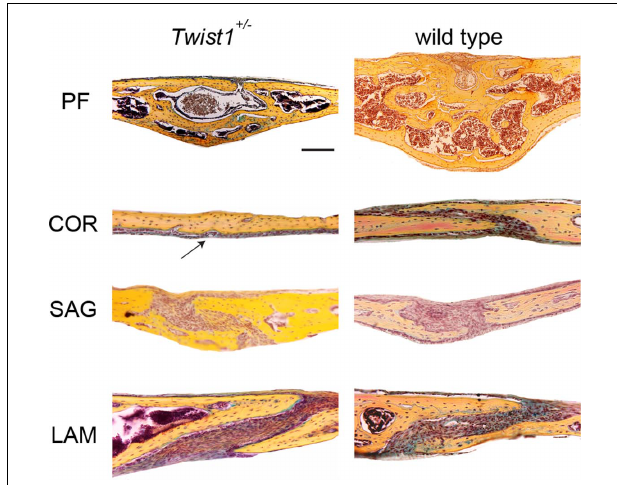
FIGURE 1 | Pentachrome staining of the four representative cranial sutures: posterior frontal (PF), coronal (COR), sagittal (SAG), and lambdoid (LAM) at postnatal day (p) 25. A complete closure of COR suture is observed in Twist1 + / − mice, while the suture remains patent in wild-type mice.The arrow indicates the fused coronal suture in Twist1 + / − mice. Scale bar: 100 μ m.